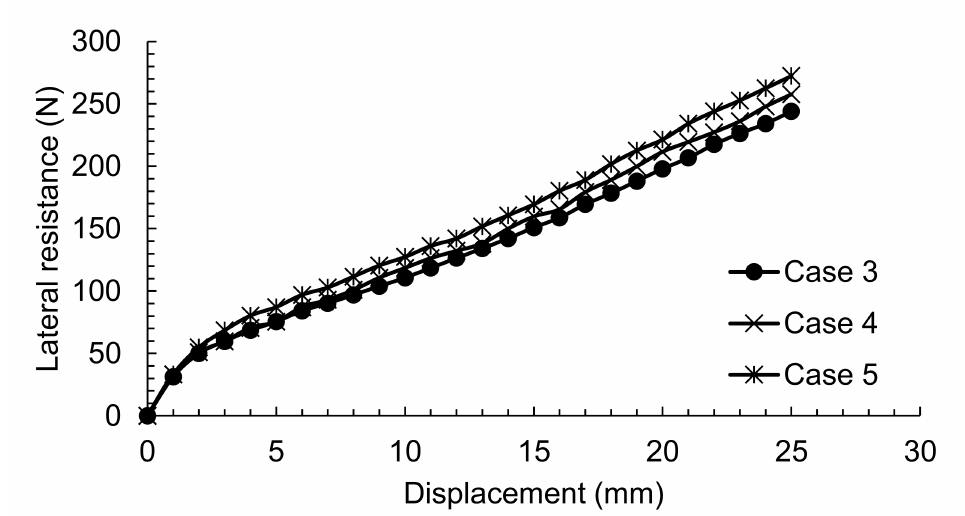
Figure 11. Lateral resistance according to the change in overhead load. Figure 12 represents the lateral resistance ratio according to the tower weight ratio.